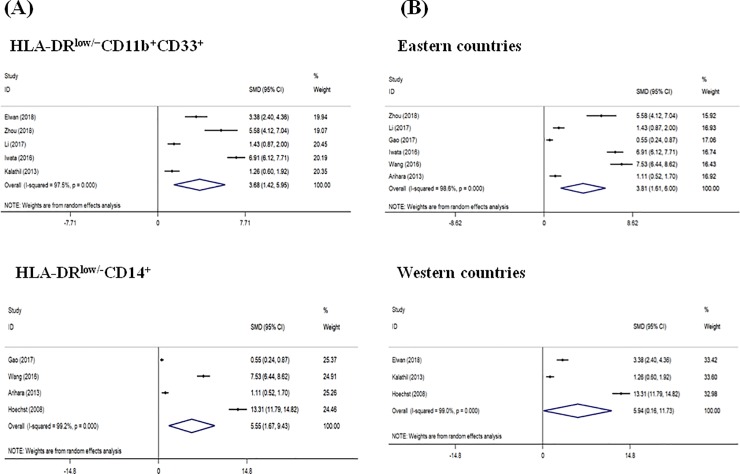
Forest plot of subgroup meta-analysis evaluating the proportion of MDSCs by the phenotypes of MDSCs (A) and geographical areas (B) in HCC patients and healthy controls.